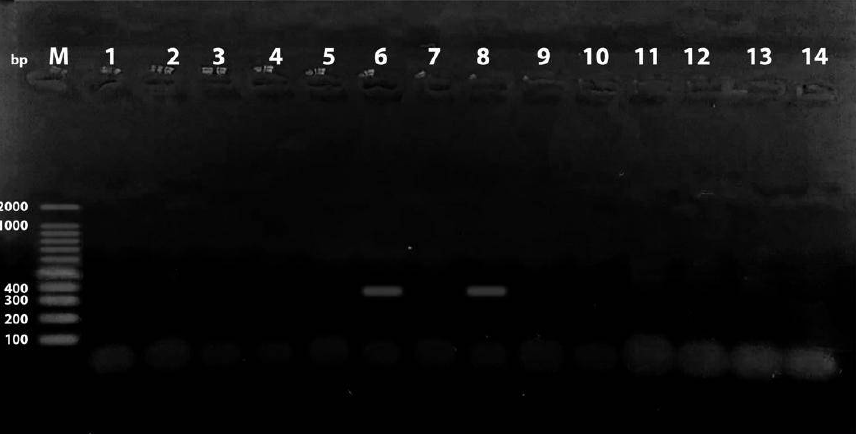
Figure 2. Multiplex PCR showing amplification of PAI IJ96 at 400 bp. Lane M: 100 bp DNA ladder; lanes 6 and 8: positive samples; lanes 1–5, 7, and 9–14: negative samples. Table 2. Pathogenicity island (PAI) markers identified in E. coli isolates from chicken and human. 140